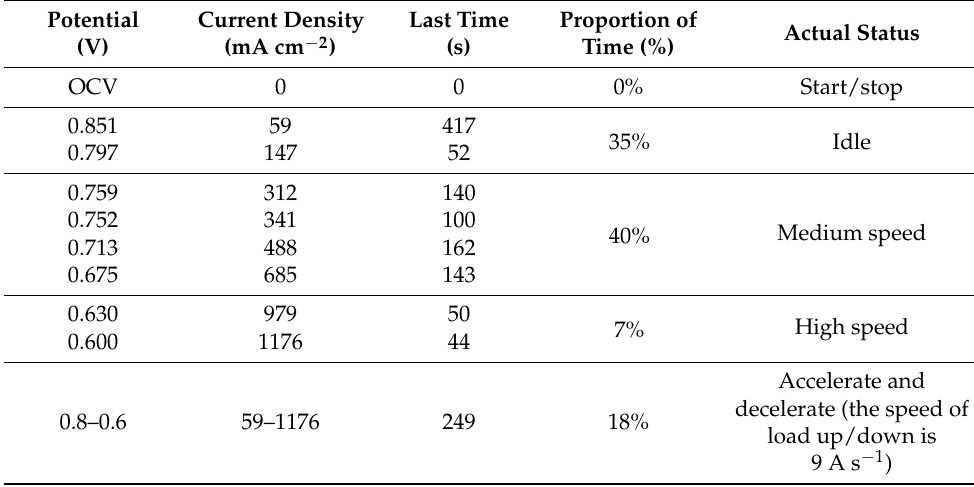
Table 1. The disassembly analysis of each stage of dynamic load cycle.